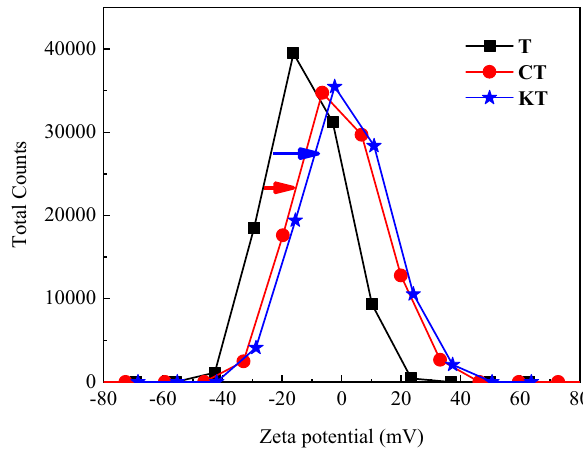
Figure 3: Zeta potential distribution of tourmaline before and after modi fi cation.